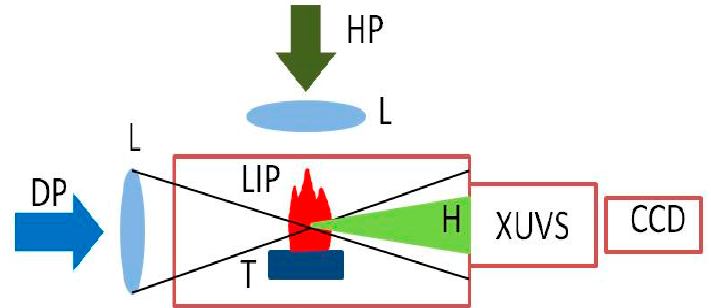
Figure 1. Experimental setup of delayed excitation of nanosecond laser produced plasma for gener- ation of high-order harmonics in carbon nanostructures contained plumes. DP: driving pulse; HP: heating pulse; LIP: laser-induced plasma; T: target; H: harmonic emission; XUVS: extreme ultraviolet spectrometer; CCD: charge-coupled device camera.